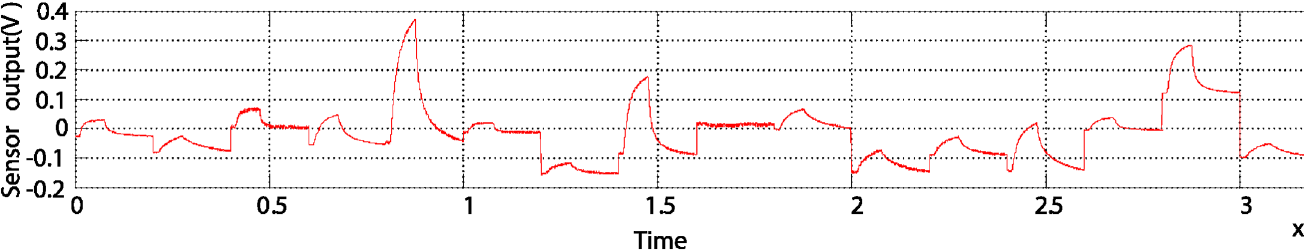
Fig 6. Representation of data sample in 32,000 dimensional vector